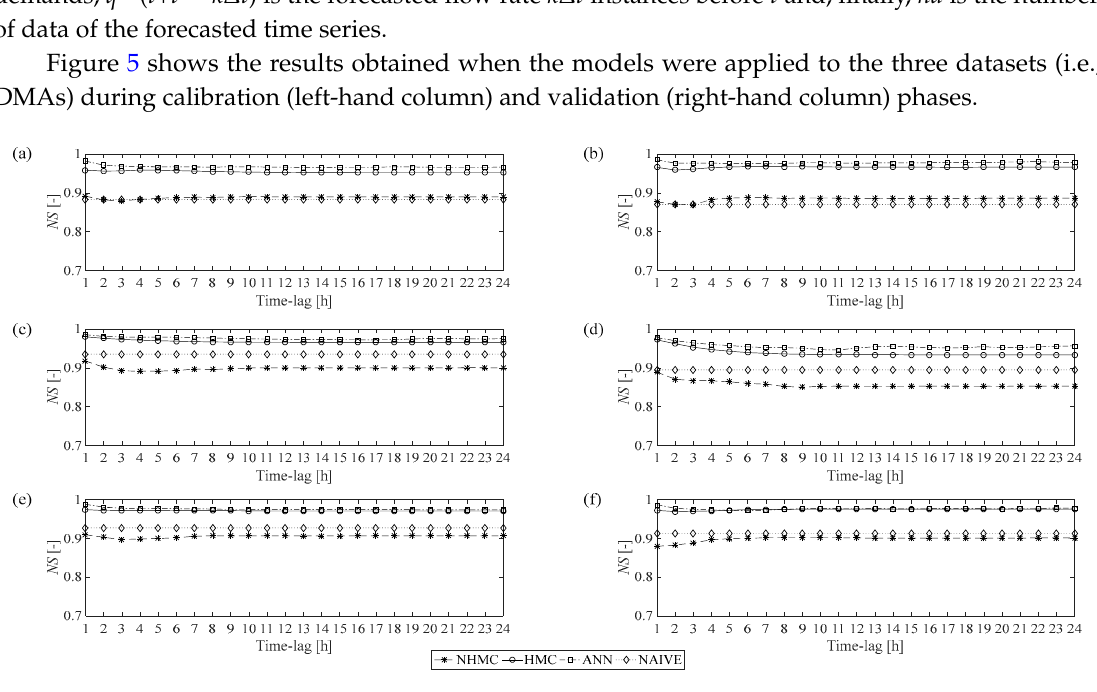
Figure 5. Nash–Sutcliffe index ( NS) values obtained by the non-homogeneous Markov chain (NHMC), homogeneous Markov chain (HMC), artificial neural networks (ANN) and naïve models applied to the calibration (left-hand column, ( a , c , e )) and validation (right-hand column, ( b , d , f )) data for DMA1 (row 1), DMA2 (row 2) and DMA 3 (row 3).